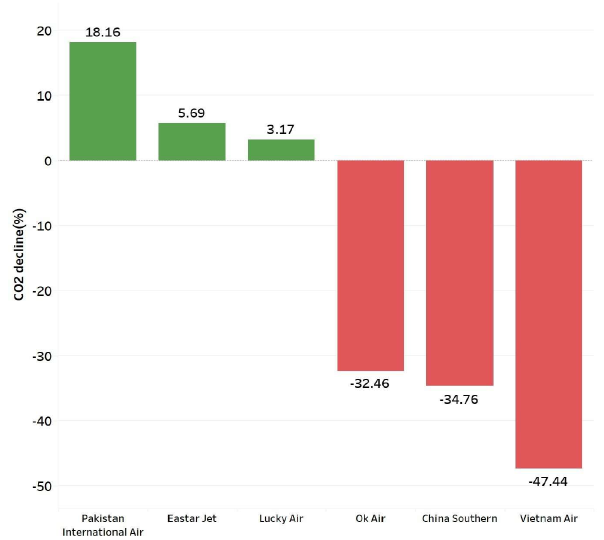
Figure 14. The impacts of CNG2020 on some popular